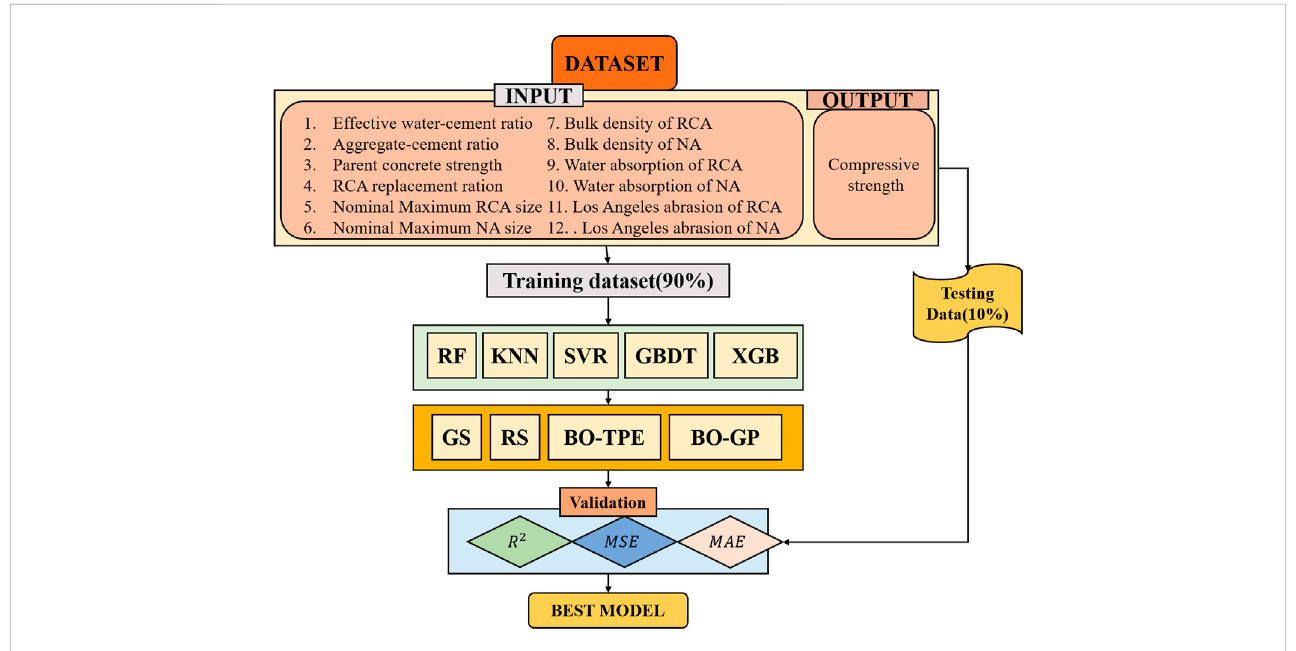
FIGURE 6 Framework of compressive strength prediction model of